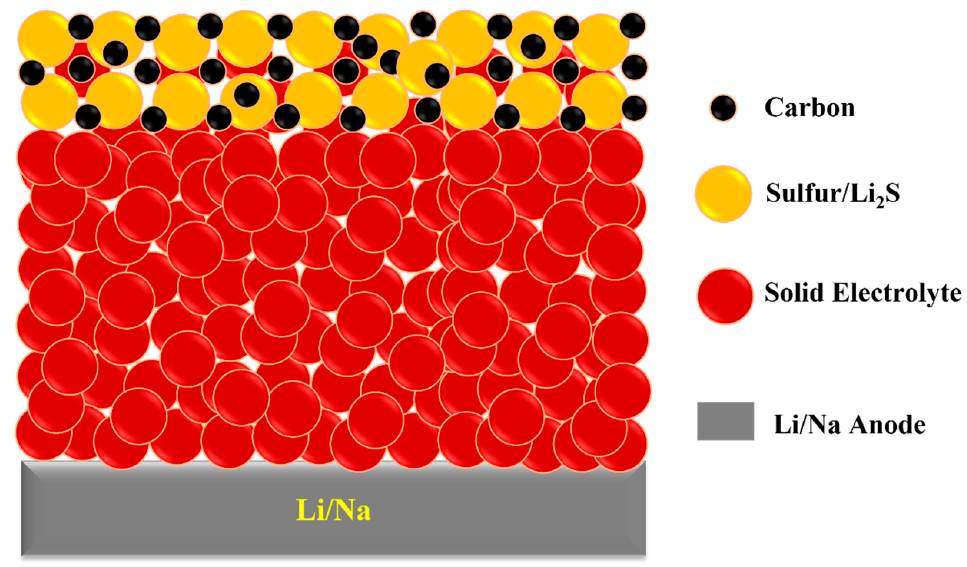
Figure 5. Schematic representation of all-solid-state metal (Li/Na) sulfur batteries.